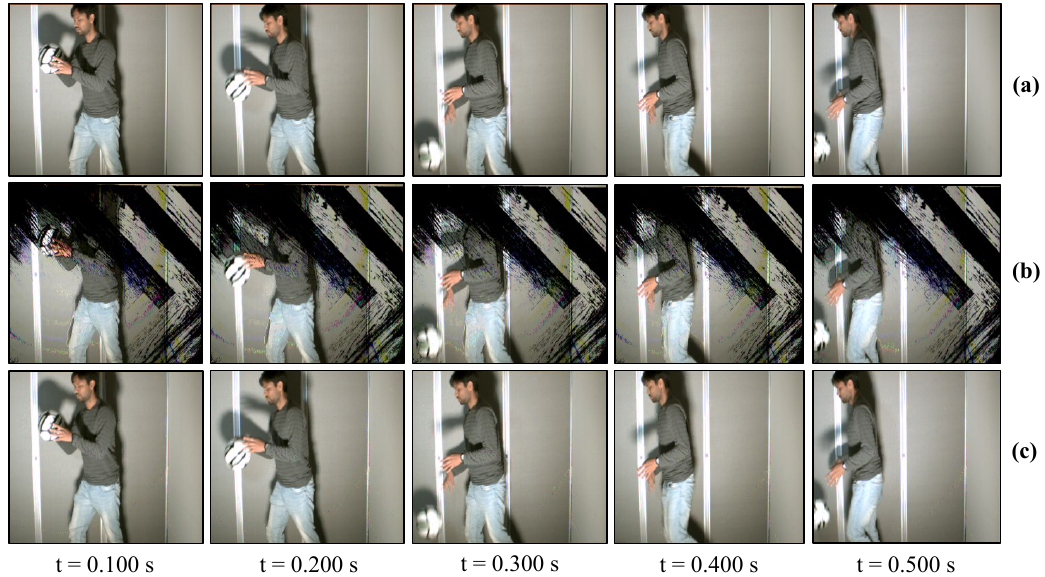
Figure 20. Reconstructed USB camera input image sequence on the pattern background: ( a ) 640 × 480 input image; ( b ) 510 × 459 binary-code image without background subtraction; and ( c ) 510 × 459 binary-code image with background